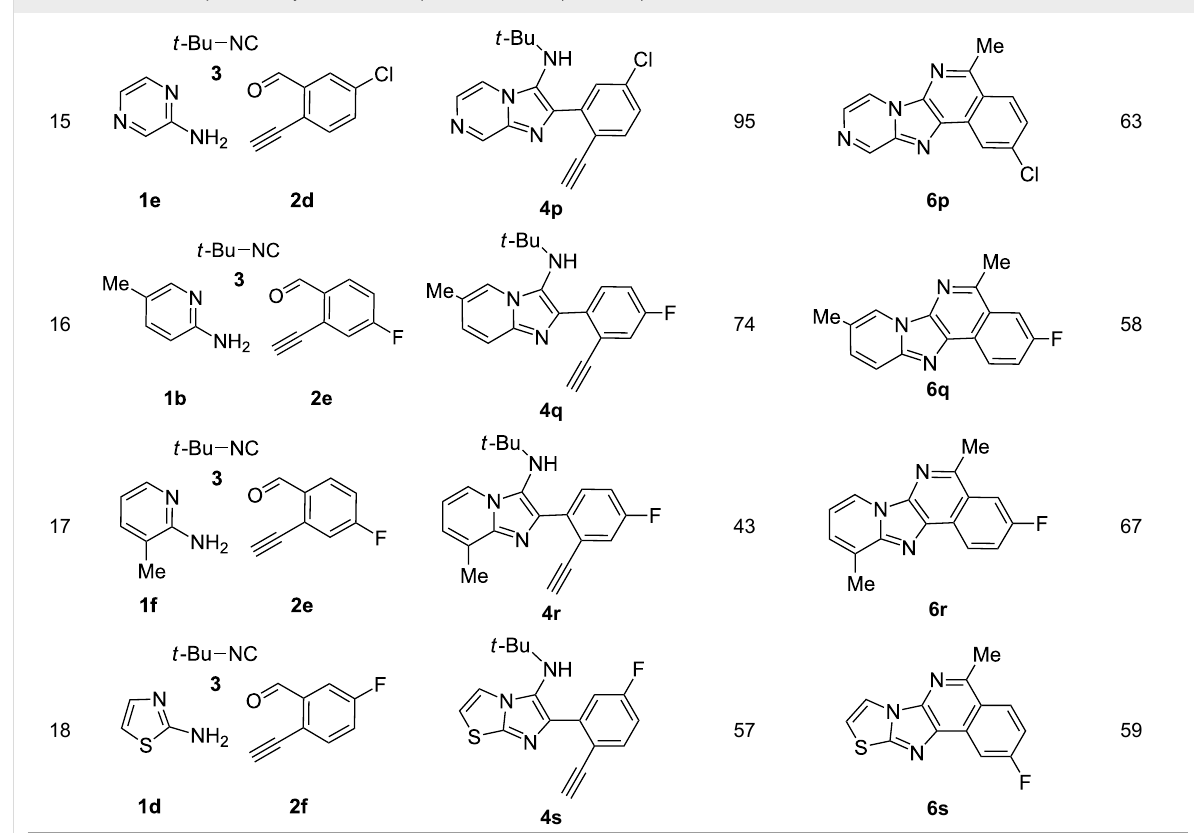
Table 2: Substrate scope for the syntheses of compounds 4 and 6 . a